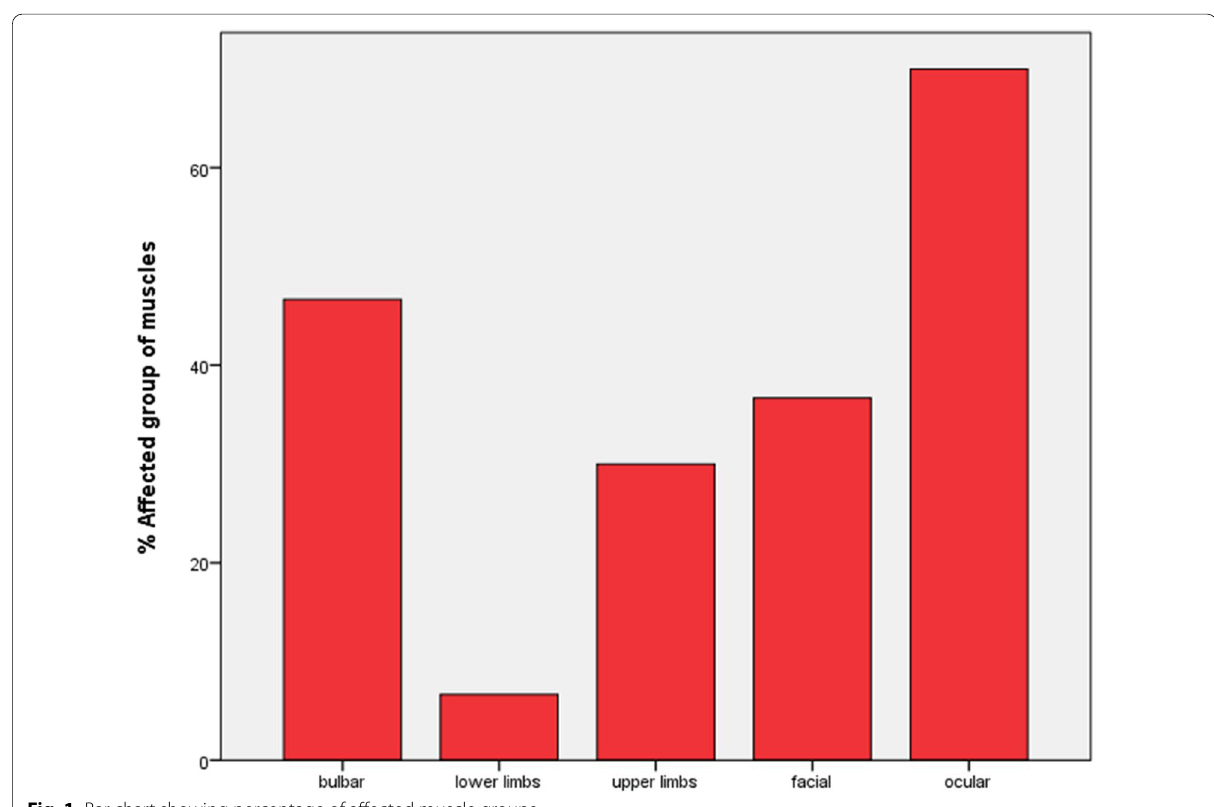
Fig. 1 Bar chart showing percentage of affected muscle